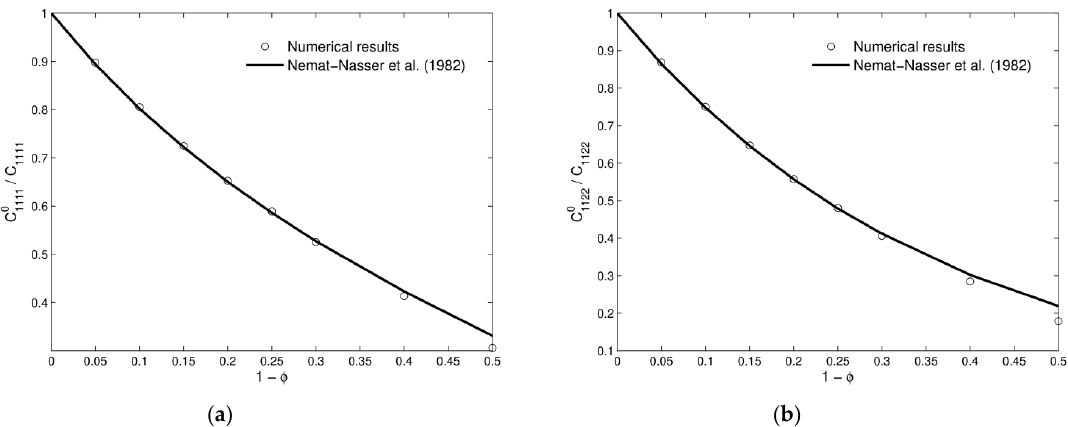
Figure 7. Characteristic deformations of solid cube with spherical void inclusion (0.05). ( a ) 𝝌 (cid:2869)(cid:2869) ; ( b ) 𝝌 (cid:2870)(cid:2870) ; ( c ) 𝝌 (cid:2871)(cid:2871) ; ( d ) 𝝌 (cid:2869)(cid:2870) ; ( e ) 𝛘 (cid:2869)(cid:2871) ; ( f ) 𝛘 (cid:2870)(cid:2871) .